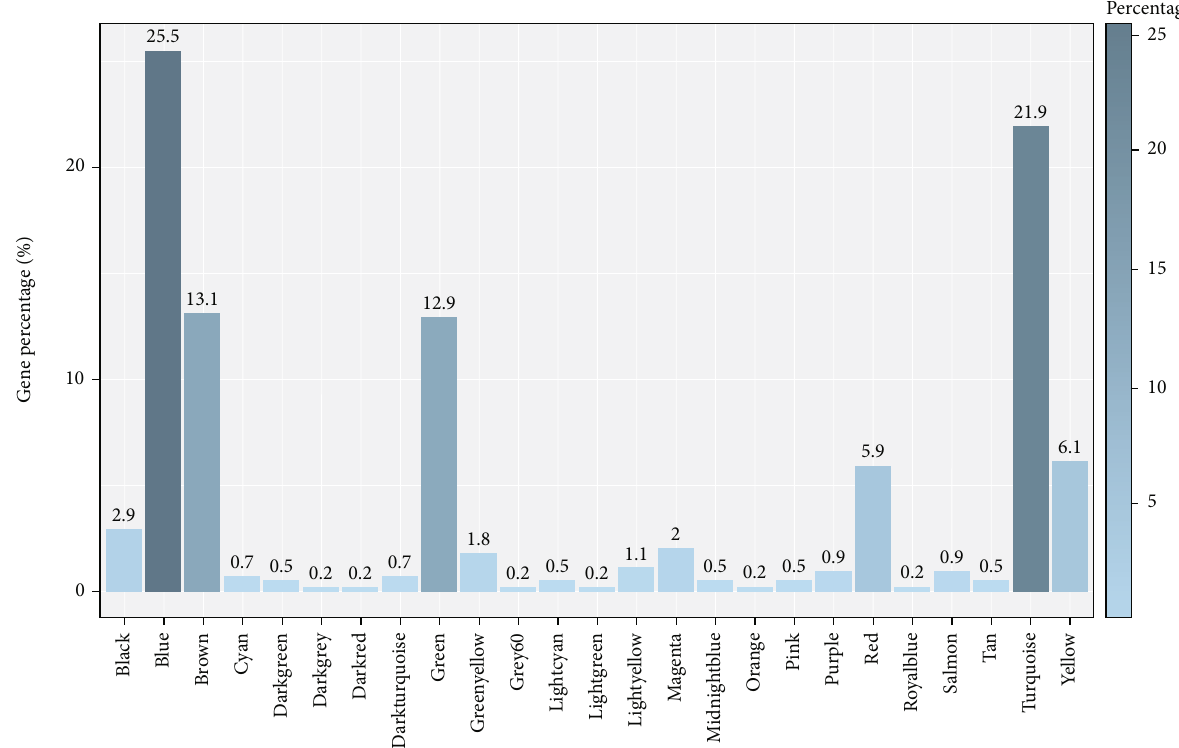
Figure 10: Distribution of EMB genes across gene modules. The coloured bars represent the ratio between the number of EMB genes in each module and the total number of EMB genes in the